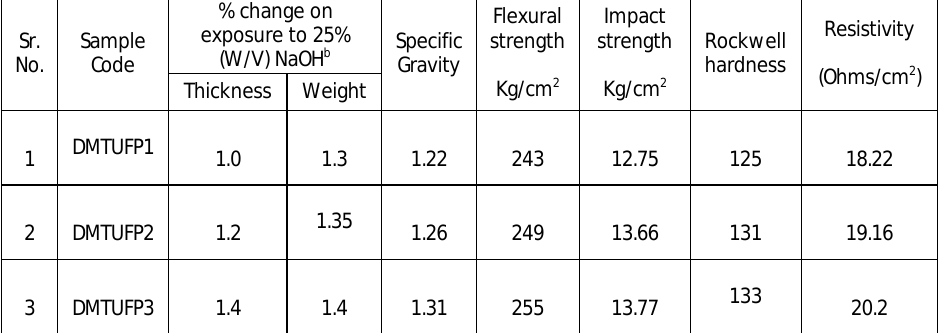
Flexural Impact Resistivity Specific strength strength Rockwell Gravity hardness (Ohms/cm 2 Kg/cm 2 Kg/cm 2